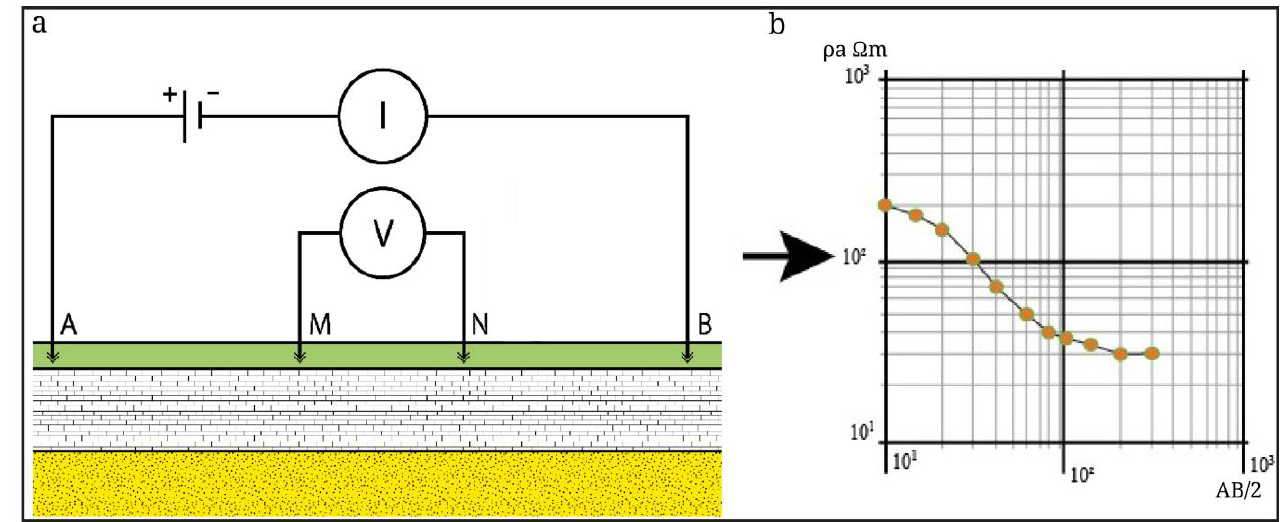
Figure 2. ( a ) General scheme of a soil-resistivity measurement using the Schlumberger configuration with a four−electrode device (ABMN), ( b ) bi−logarithmic diagram for the representation of VES measurements.